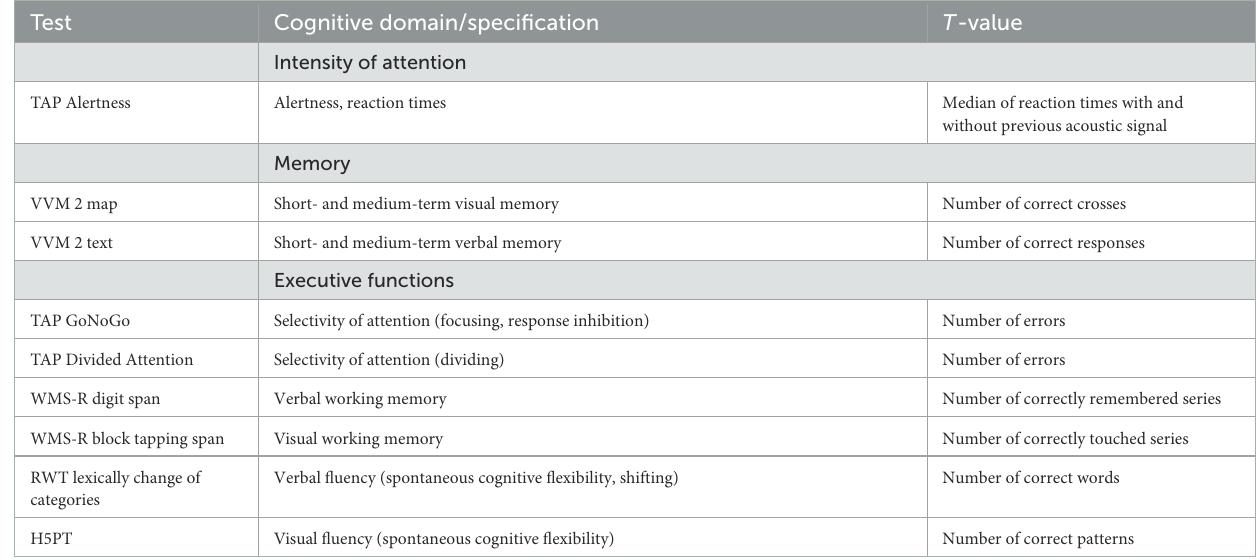
TABLE 1 Distribution of neuropsychological tests and assessed variables according to subdivision into the three cognitive areas intensity of attention, memory, and executive